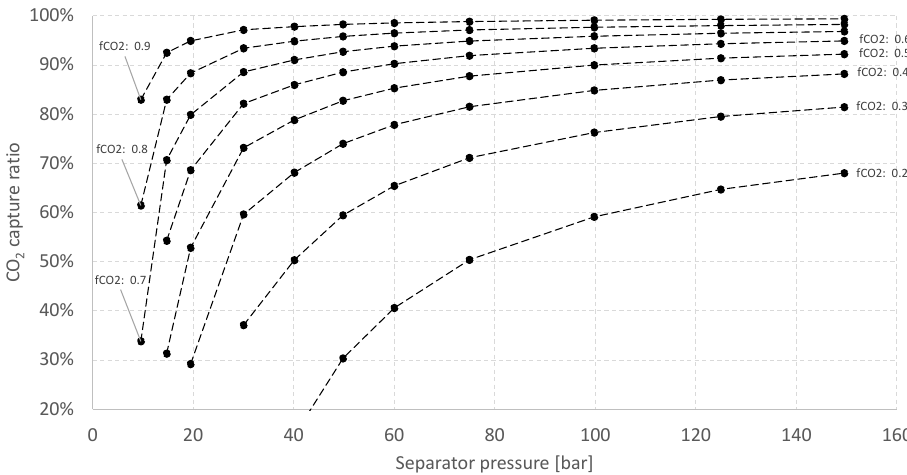
Figure 4. Estimated CO 2 capture ratio for phase separation of a binary H 2 /CO 2 mixture.